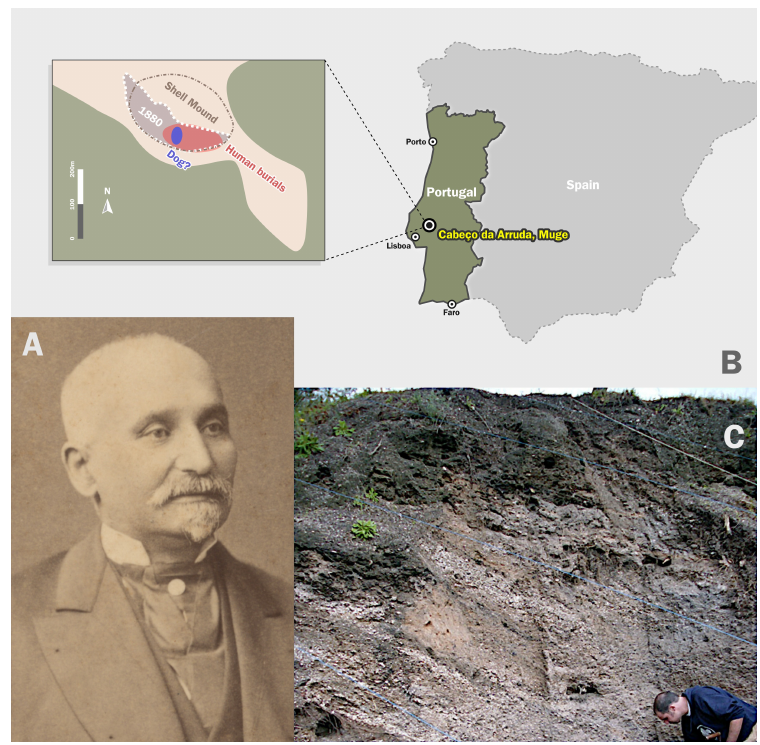
Figure 1. ( A ) A portrait of the archaeologist Carlos Ribeiro, who excavated the Muge dog in 1880 (photograph kindly shared by Prof JL Cardoso [7]); ( B ) map of the Iberian Peninsula displaying the Cabeço da Arruda shell middens location with detail about the place where human burials and the Muge dog were found. There is some imprecision regarding the exact place from where the dog was excavated. Adapted from (Cardoso and Rolão 2000) [8]; ( C ) section of the Cabeço da Arruda stratigraphic complex profile (photograph kindly shared by Anabela Joaquinito), since it shows how the superficial layer and the others below lie in different directions. Additionally, the layers have been disturbed by animal